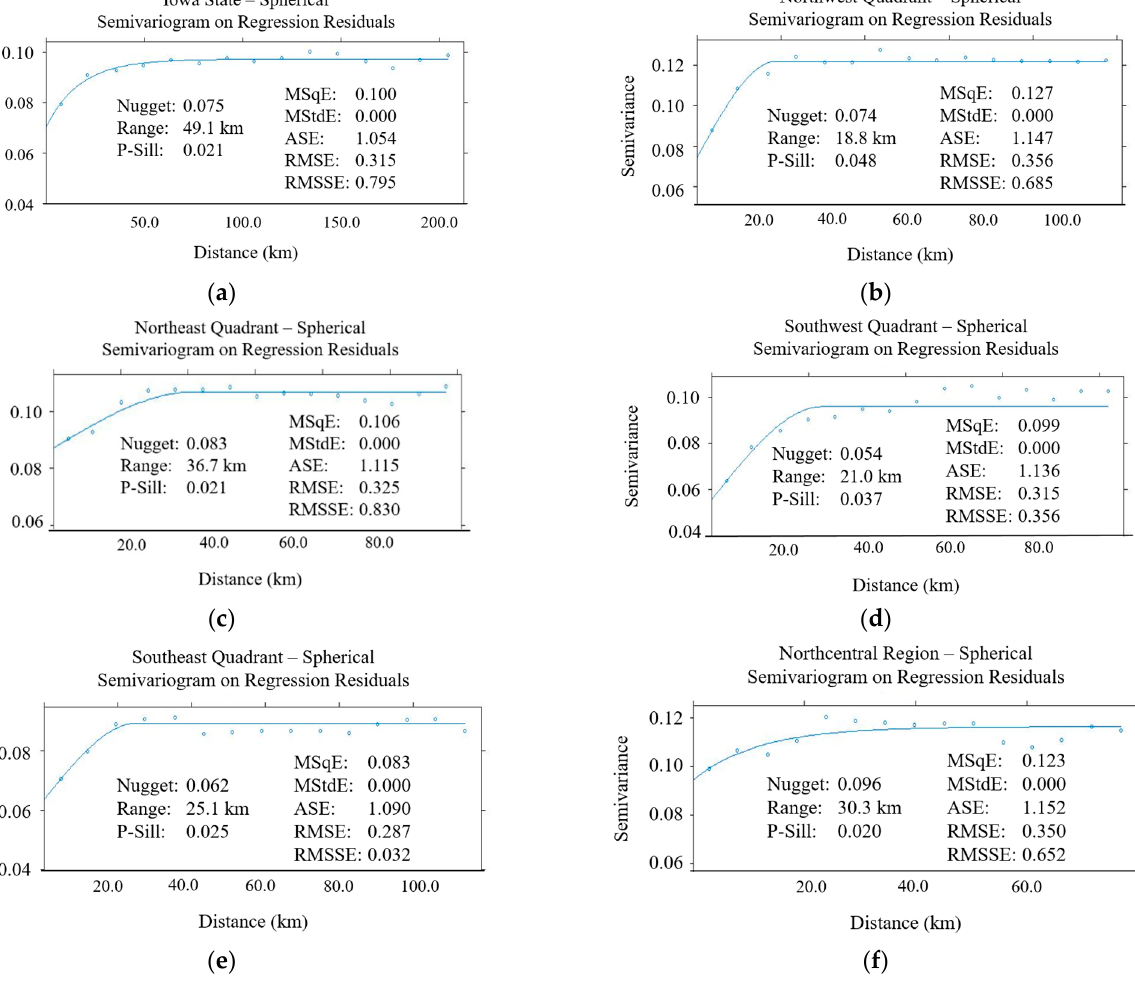
Figure 12. Spherical model semivariograms for ( a ) Iowa State, ( b ) Northwest Iowa, ( c ) Northeast Iowa, ( d ) Southwest Iowa, ( e ) Southeast Iowa, and ( f ) Northcentral Iowa.